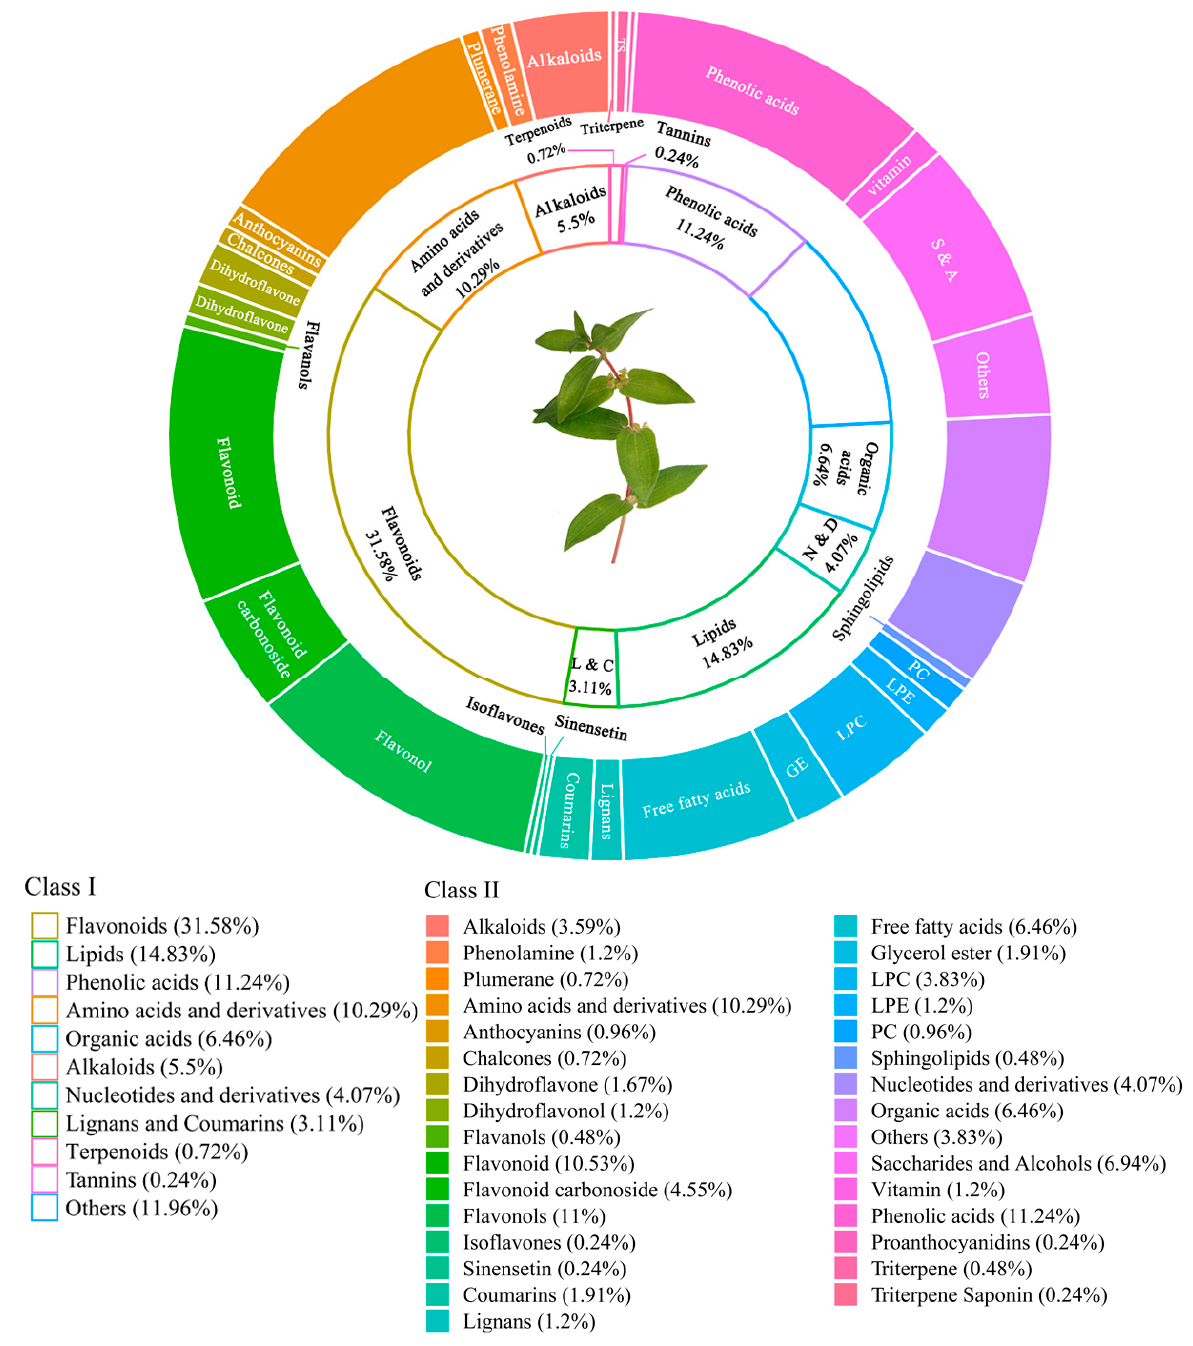
Figure 1. Percentage of metabolite substance types of Gonostegia hirta by UPLC-MS/MS . The inner circle shows the 11 major groups into which the 418 metabolites are divided, namely, flavonoids, lipids, phenolic acids, amino acids and derivatives, organic acids, alkaloids, nucleotides and derivatives (N and D), lignans and coumarins (L and C), terpenoids, tannins, and others. The outer circle is a subdivision of the 11 major groups, namely, alkaloids, phenolamine, and plumerane of alkaloids; anthocyanins, chalcones, dihydroflavone, dihydroflavonol, flavanols, flavonoid, flavonoid carbonoside, flavonols, and isoflavones of flavonoids; sinensetin, coumarins, and lignans of L and C; free fatty acids, glycerol ester (GE), lysophosphatidylcholine (LPC), lysophosphatidylethanolamine (LPE), phosphatidylcholine (PC), and sphingolipids of lipids; N and D and organic acids; saccharides and alcohols (S and A) and vitamin of others; phenolic acids and proanthocyanidins of tannins; triterpene and triterpene saponin (TS) of